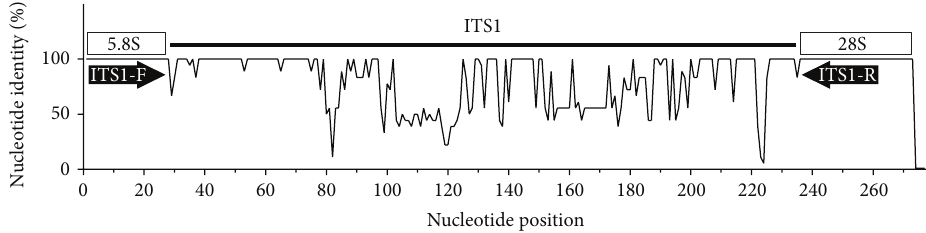
Figure 1: Percent nucleotide identity in the ITS1 rRNA region of isolates of Fusarium species based on sequences deposited in the NCBI database. Novel oligonucleotide primers have been designed on the basis of conserved parts of the 5.8S rRNA region (primer ITS1-F: CGAATCTTTGAACGCACAT) and of the 28S rRNA region (primer ITS1-R: TAAGTTCAGCGGGTATTCCTAC). Sequences of the ITS1 region are variable among different